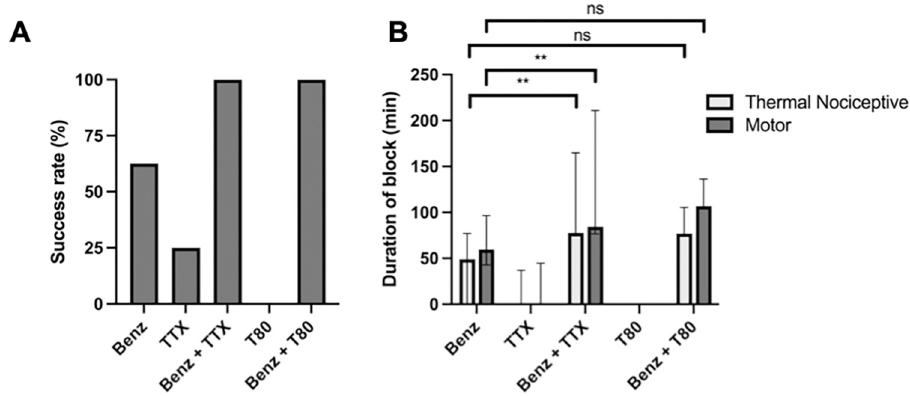
Fig 3. Effect of co-administration of benzonatate (Benz, 12.4 mM) with TTX (30 μ M) or T80 (23 mM). (A) frequency of successful sensory nerve block (B) duration of sciatic sensory and motor nerve block. Data are medians with 25 th and 75 th percentiles, n = 8 per group except benzonatate administration with n = 12 (note that administration of T80 alone resulted in no sensory or motor block for all animals). Duration of nerve block were compared by a Kruskal-Wallis test (p = 0.0001) with post-hoc pairwise comparison with Bonferroni correction (p < 0.01 for sensory and motor blockade following co-administration of benzonatate and TTX compared to benzonatate alone).